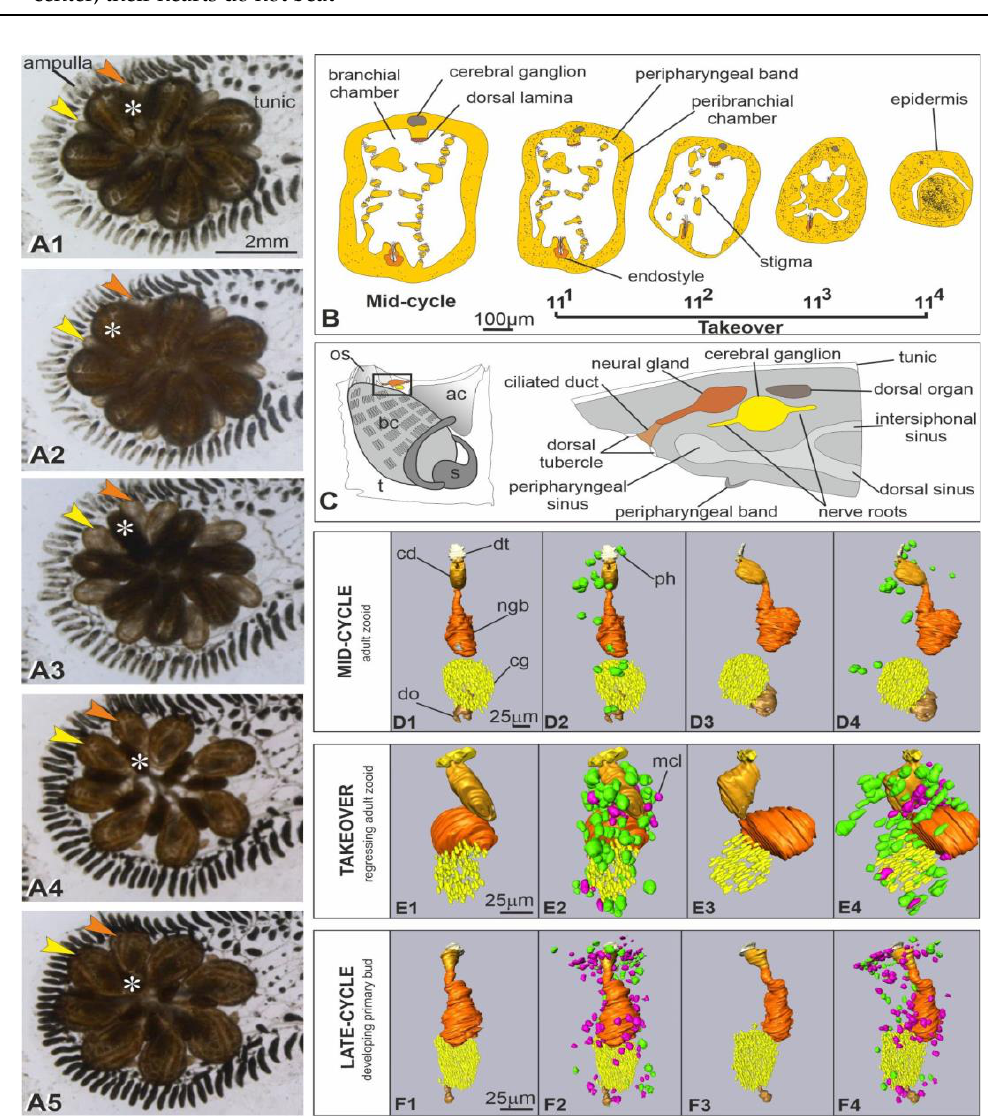
Figure 1. ( A ) Colony of Botryllus schlosseri photographed in late-cycle ( A1 ) and during takeover. ( A2 ): adult zooids in sub-stage 11 1 ; ( A3 ): sub-stage 11 2 ; A4: sub-stage 11 3 ; ( A5 ): sub-stage 11 4 . The adult zooids (asterisk) progressively reduce to a dark round mass at the system center; in the meantime, primary buds (arrowheads) grow and open their siphons, becoming the new adult generation. Secondary buds are not recognizable In the system, each adult zooid possesses its own oral siphon (not visible in ventral view), whereas the atrial siphon is a common aperture at system center. The yellow and orange arrowheads point at the right and left primary buds belonging to the zooid, marked by asterisk, respectively. Ventral view. a: ampulla; t: tunic. The enlargement is the same in ( A1 – A5 ). ( B ) Illustrations of zooid transverse sections in mid-cycle and during takeover (stages 11 1 – 11 4 ). In the latter, note the progressive contraction of the adult zooid, the dissolution of inner organs and the increase in immunocytes (black dots). Filter-feeding zooids relay on filtration for feeding